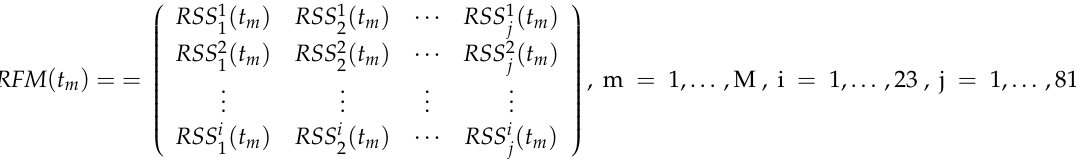
Table 4. Structure of the collected dataset in the fingerprinting offline phase.